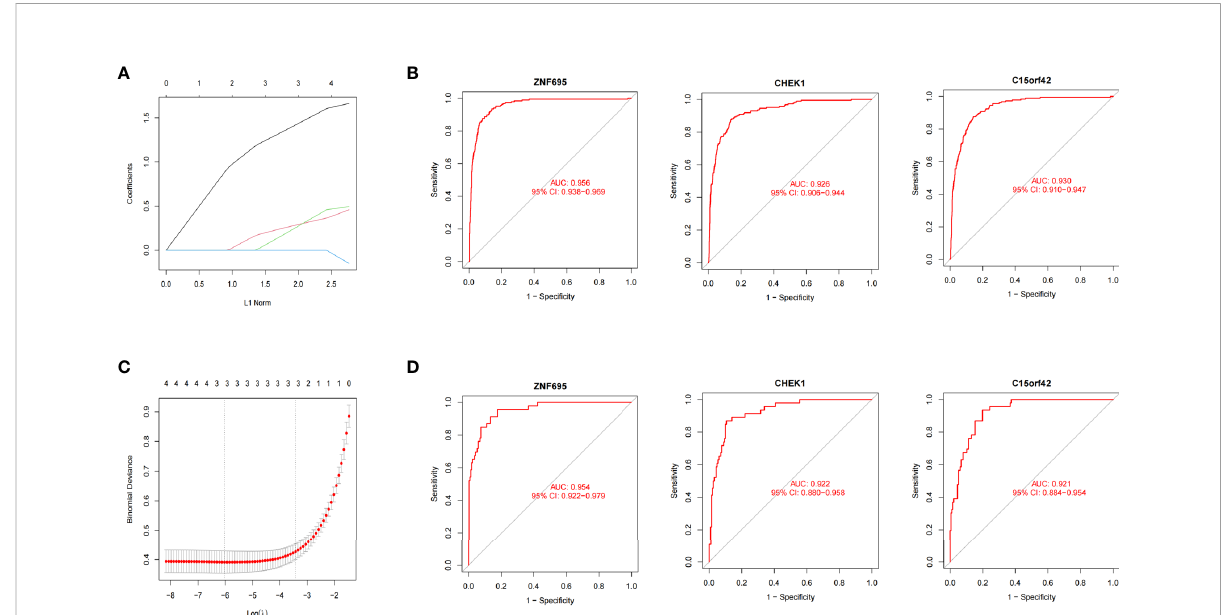
FIGURE 6 MYCN positive NB model constructed by Lasso and Roc regression analysis (A) Ten-fold cross-validation of tuning parameter selection in Lasso models. (B) Lasso coef fi cient curves of four MYCN closely related DEGs. ZNF695 , CHEK1 and C15ORF42 were eventually screened out. (C) The Roc curves of the three hub genes in 1136 cases. (D) The Roc curves of the three hub genes in the validation set of